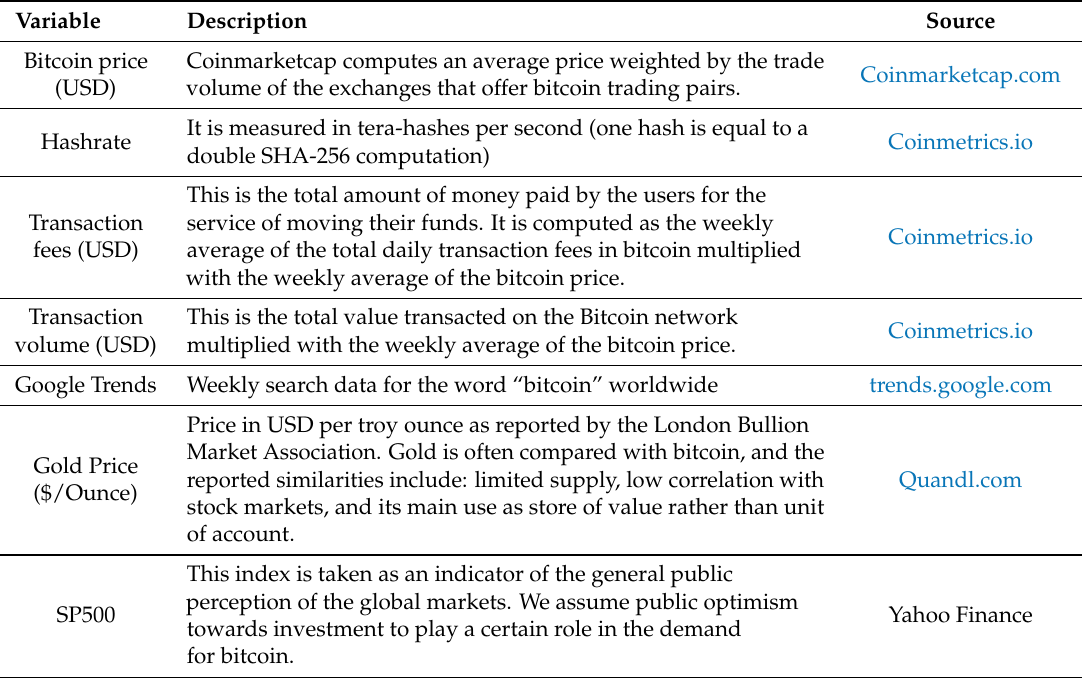
Table 1. Description of the explanatory variables used in the